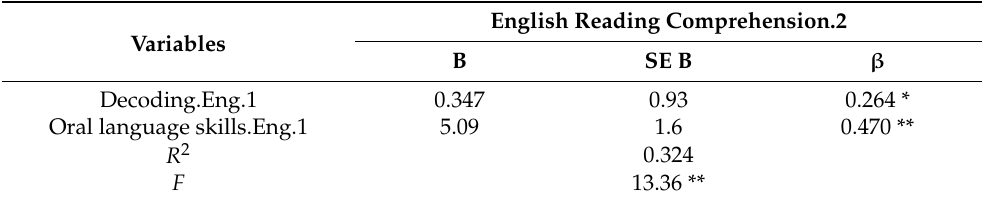
Table 5. Summary of multiple regression analysis for variables predicting bilingual children’s reading comprehension performance in English ( N =